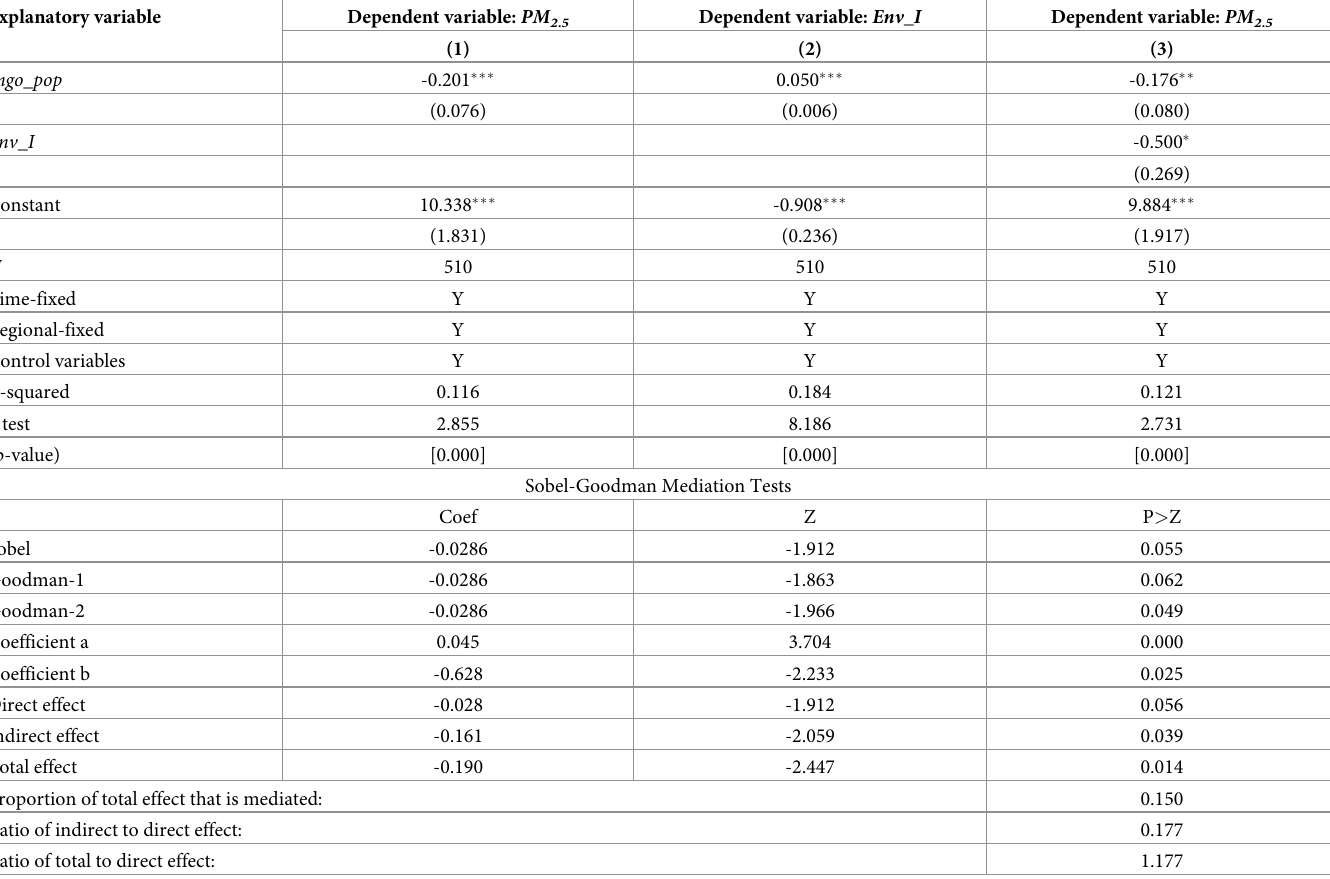
Table 7. Results of mediation effect